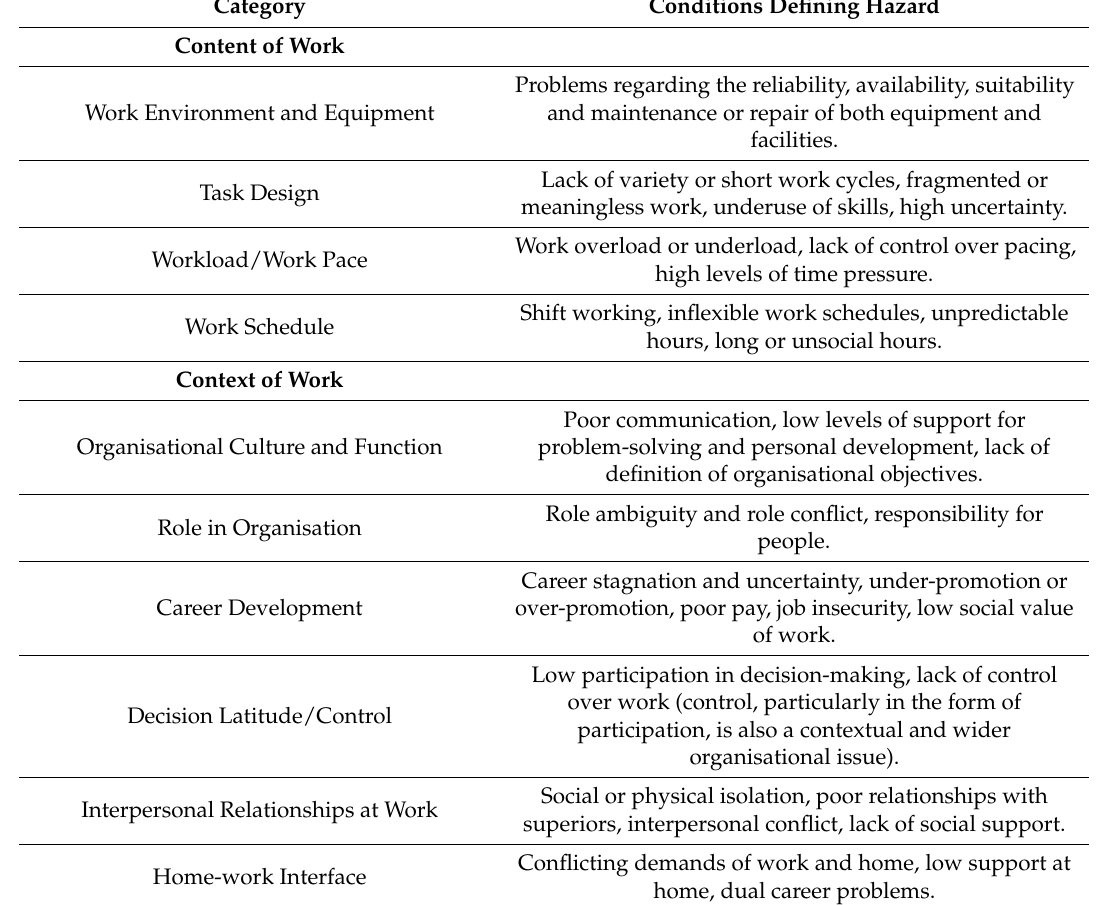
Table A1. Stressful characteristics of